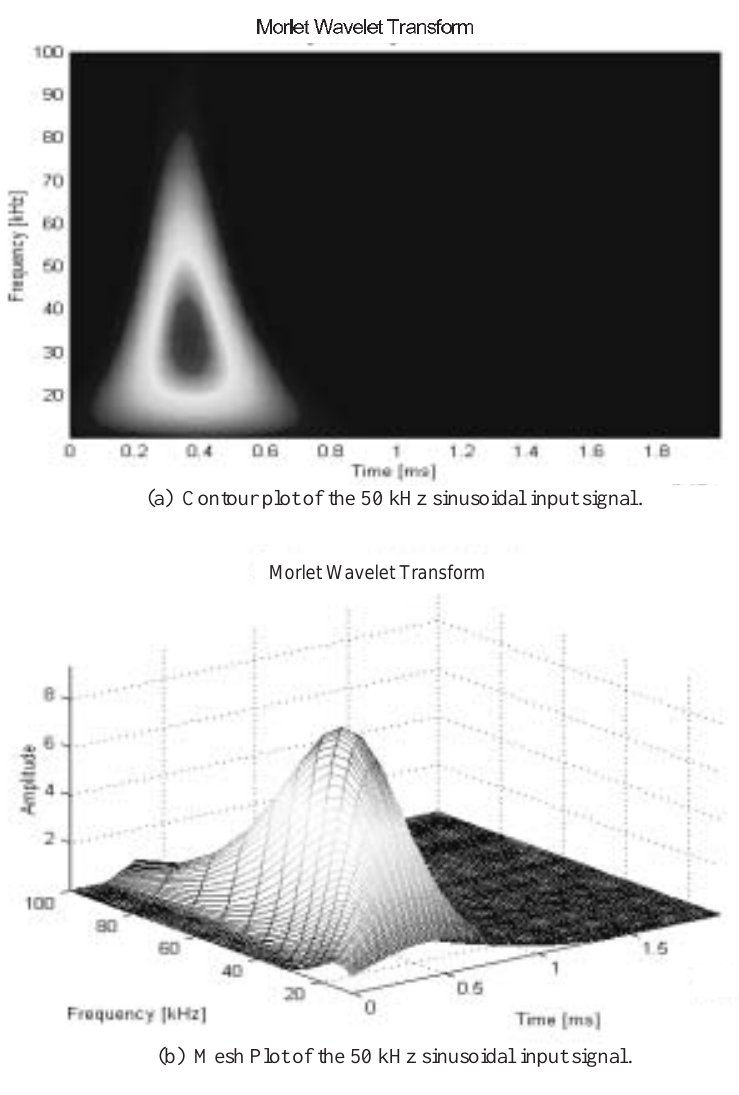
Fig. 19. Wavelet plots of the 50 kHz sinusoidal input signal. (a) Contour plot of the healthy response from sensor S4. (b) Mesh plot of the healthy response from sensor